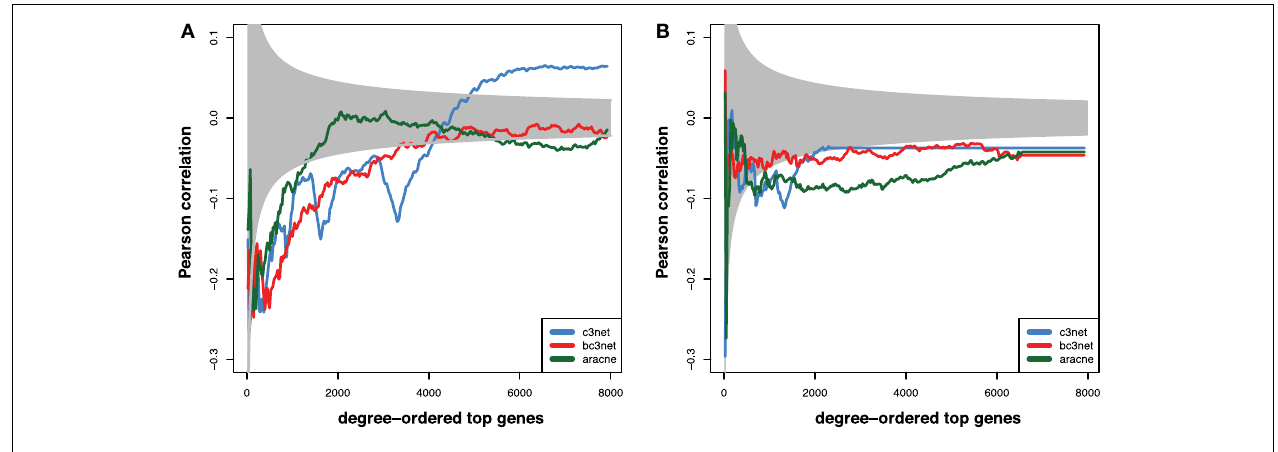
centrality values and the size of the underlying profile vectors increases with the number of the gene rank. The gray area indicates correlation values that are not statistically significant for α = 0 .